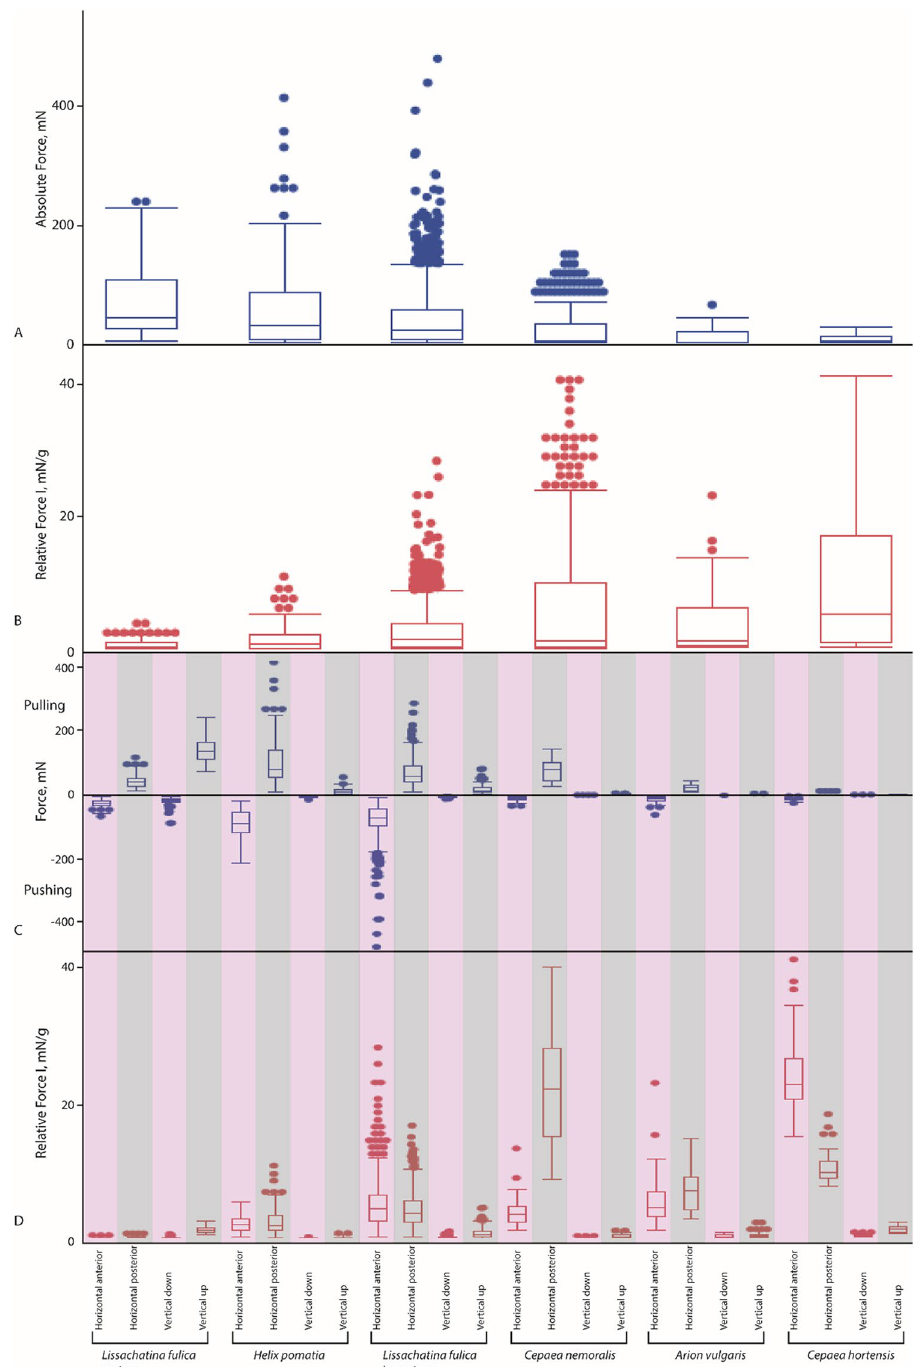
Figure 4. Absolute Force (blue boxplots) and Relative Force I (red boxplots) for distinct cohorts. ( A ) Absolute Force (regardless of the direction of measurement). ( B ) Relative Force I (regardless of the direction of measurement). ( C ) Absolute Force sorted to directions. ( D ) Relative Force I sorted to directions. For values of C and D see Supplementary Table 2. Pink = pushing of radula, grey = pulling of